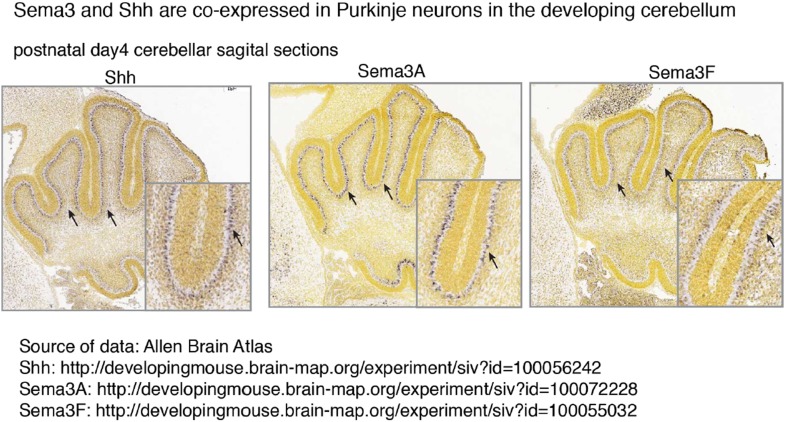
Sema3 and Shh are co-expressed in Purkinje neurons in the developing cerebellum.Multiple Sema3 isoforms are co-expressed with Shh in Purkinje neurons in the developing cerebellum. In situ hybridization results are from Allen Brain Atlas. Arrows point to the cell bodies of Purkinje neurons.